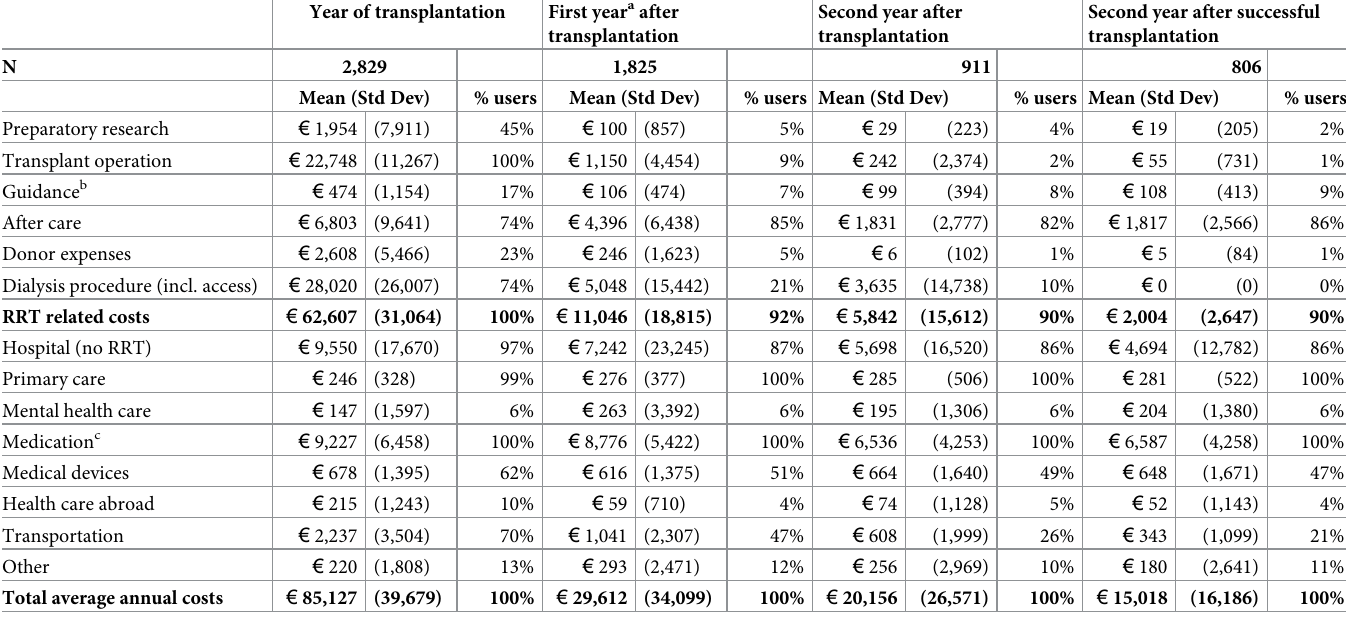
Table 4. Total average annual healthcare costs per phase of